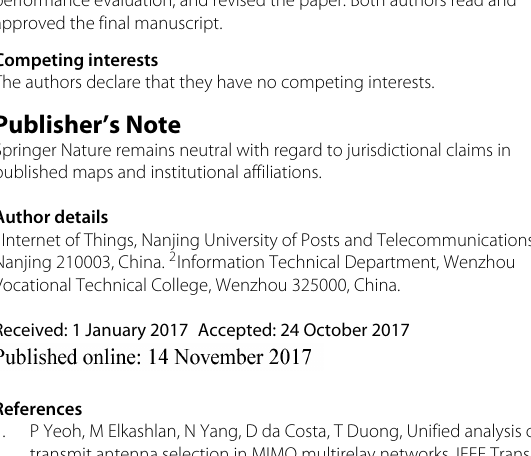
with the Taylor series expansion and the S-procedure approaches were proposed in handing the formulated non-convex optimization problem optimally. Simulation results not only demonstrated an interesting trade-off between the considered conflicting objectives, but also showed the efficiency of our proposed robust resource allocation